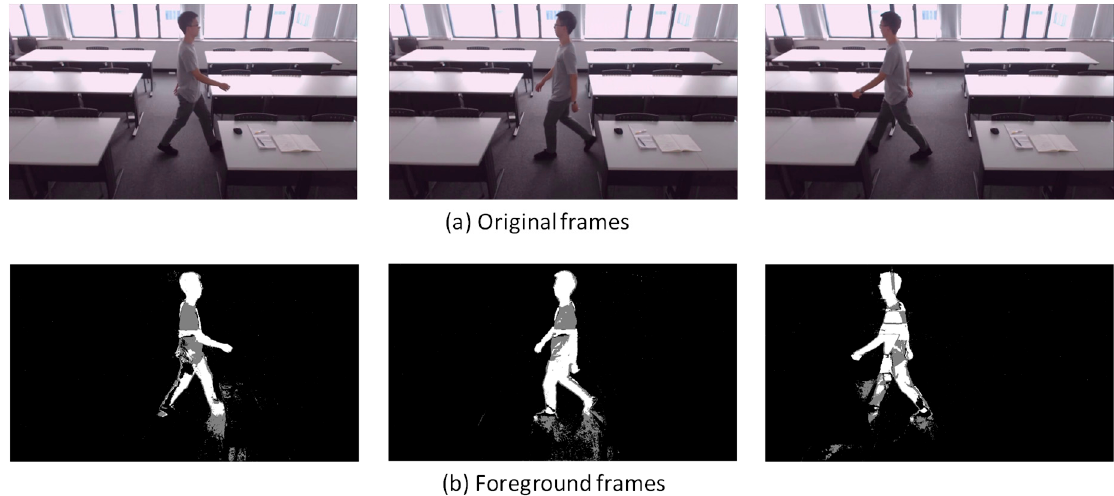
Figure 7. Walking (1.8 m/s)—sample images.